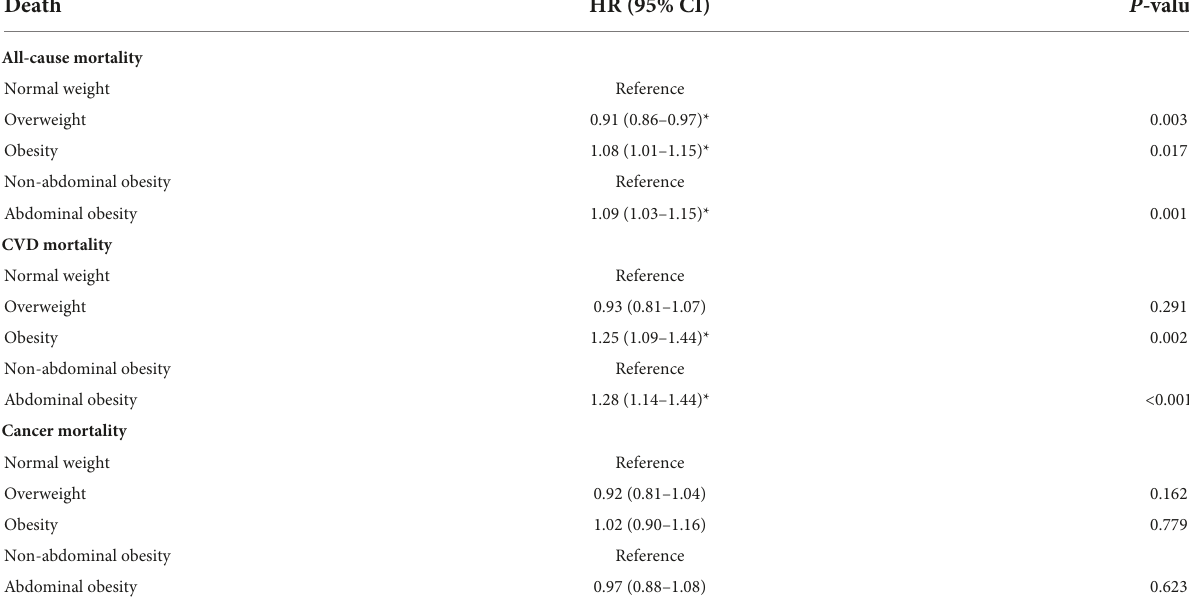
TABLE 2 The associations of different obesity levels with all-cause and cause-specific mortality in NHANES III and NHANES 2001–2014: HRs (95% CIs) for different BMI categories.